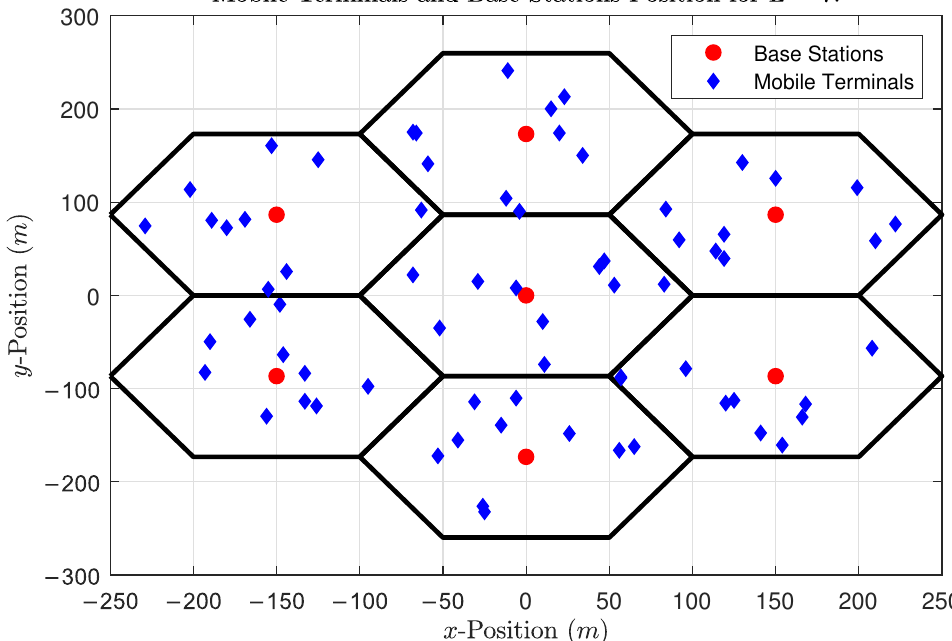
Figure 1. Base stations, users and cells geographic disposition in our simulation scenario. User positions were randomly generated.